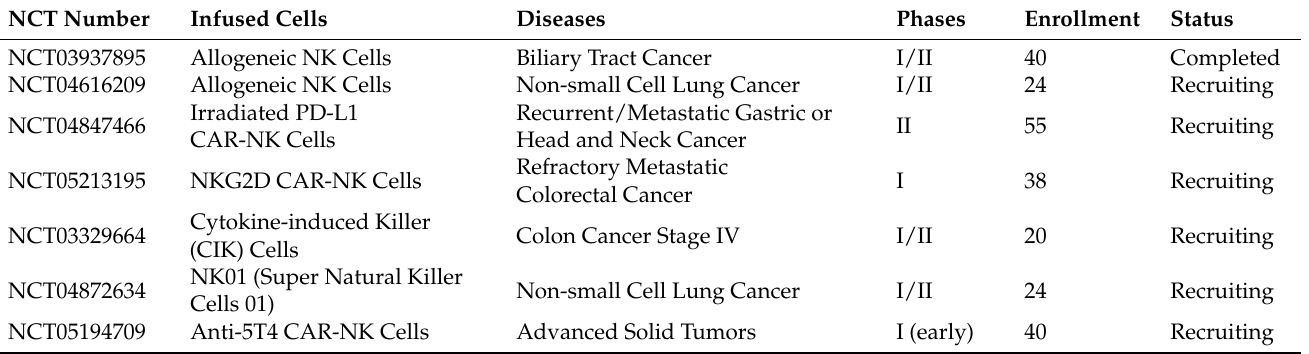
Table 4. Clinical trials of NK cells for cancer immunotherapy listed on